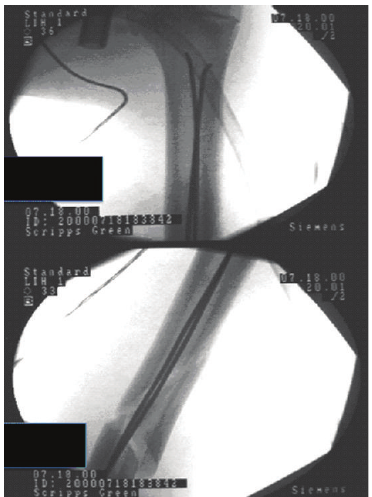
Figure 2: Intraoperative imaging showing excellent closed reduc- tion and internal fixation with nonlocked, flexible intramedullary nails inserted in a retrograde